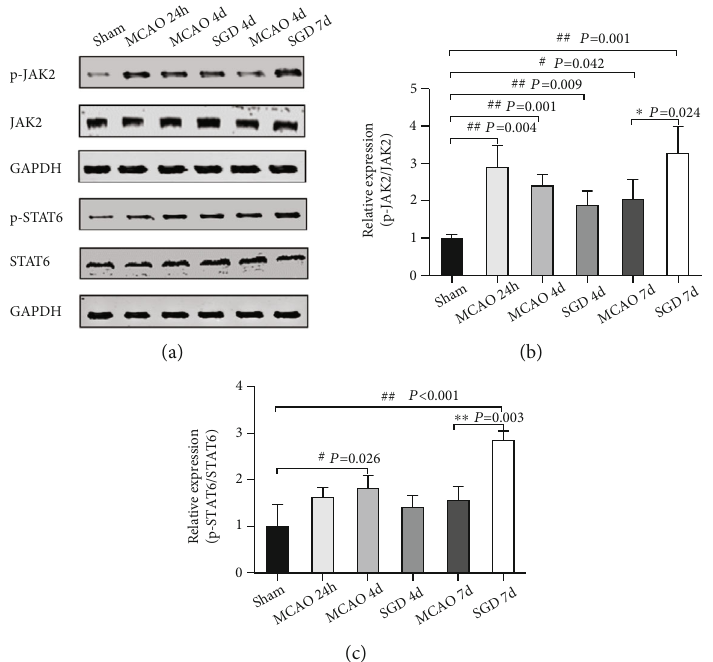
Figure 7: SGD-activated JAK2/STAT6 pathway is involved in IL-13-mediated microglia polarization following CI/RP in rats. The protein expression of JAK2, p-JAK2, STAT6, and p-STAT6 in extracts of the penumbra among the sham, MCAO, and SGD groups was analyzed by western blotting at the 3 indicated time points. (a) Representative bands of JAK2, p-JAK2, STAT6, p-STAT6, and GAPDH are shown. In this section, a statistical process was carried out on the ratios of p-JAK2/JAK2 (b) and p-STAT6/STAT6 (c). The results are presented as mean ± SD , n = 3 for each group. # P < 0 : 05 , ## P < 0 : 01 vs. sham; ∗ P < 0 : 05 , ∗∗ P < 0 : 01 vs.